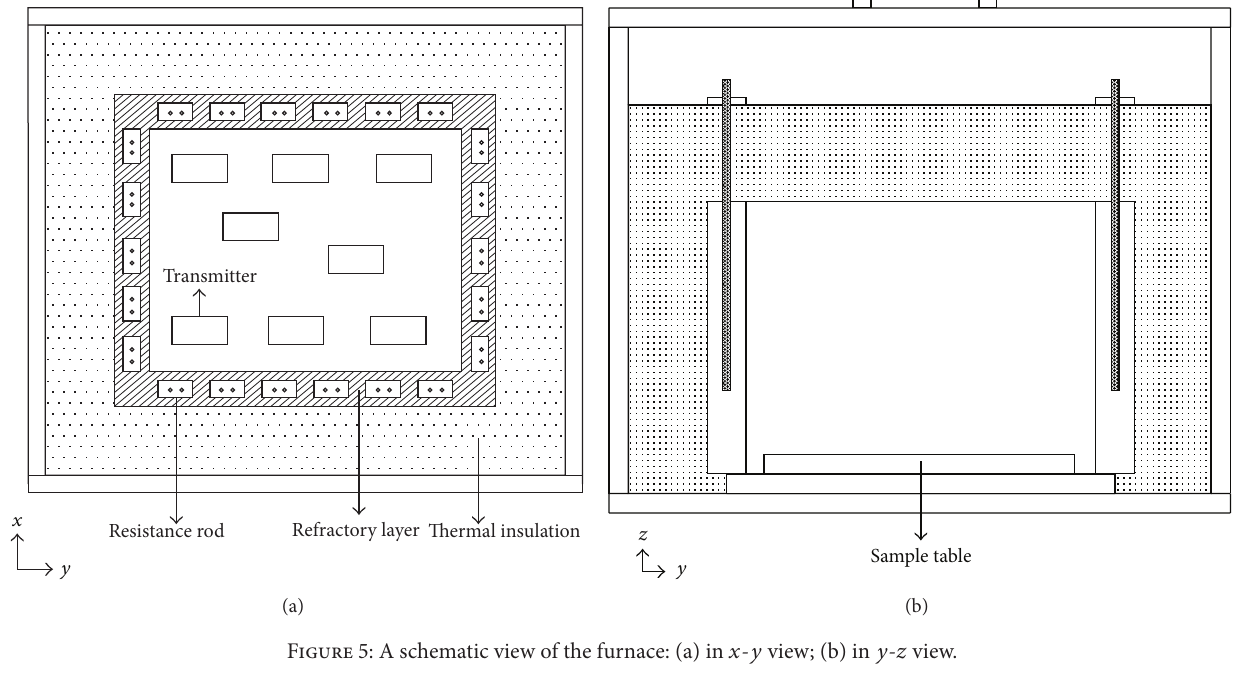
Figure 5: A schematic view of the furnace: (a) in 𝑥 - 𝑦 view; (b) in 𝑦 - 𝑧 view.